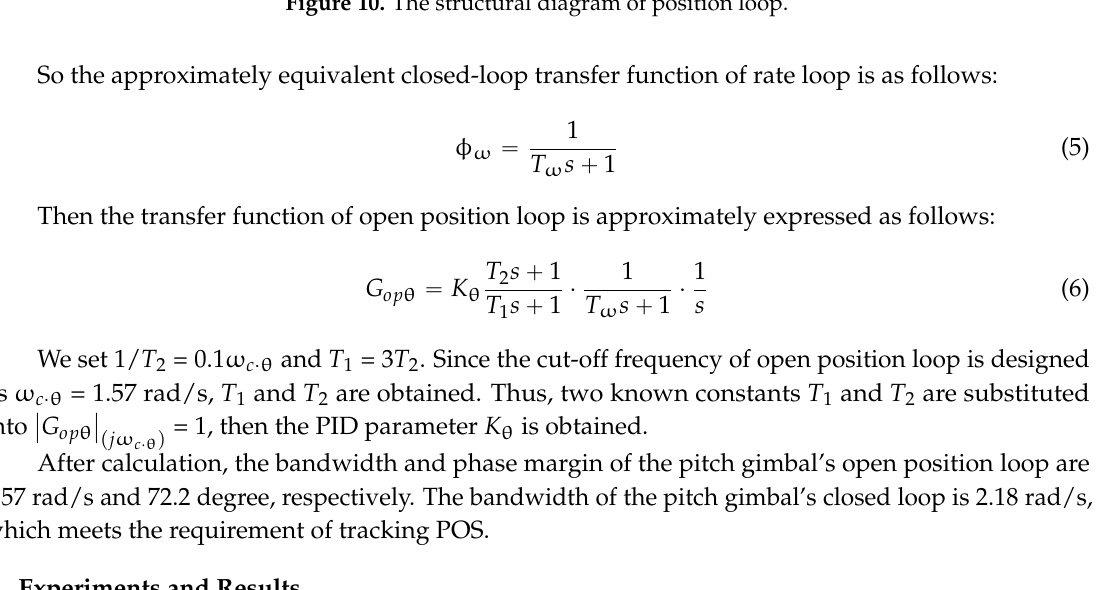
Figure 10. The structural diagram of position loop.